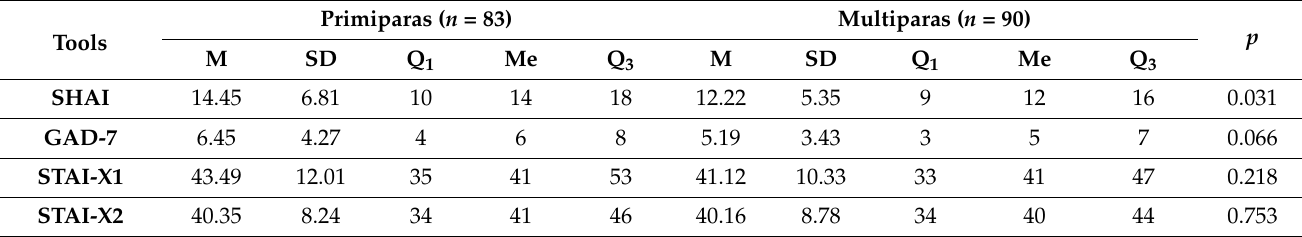
Table 3. Comparison of primiparas and multiparas for SHAI, GAD-7, and STAI. Tools